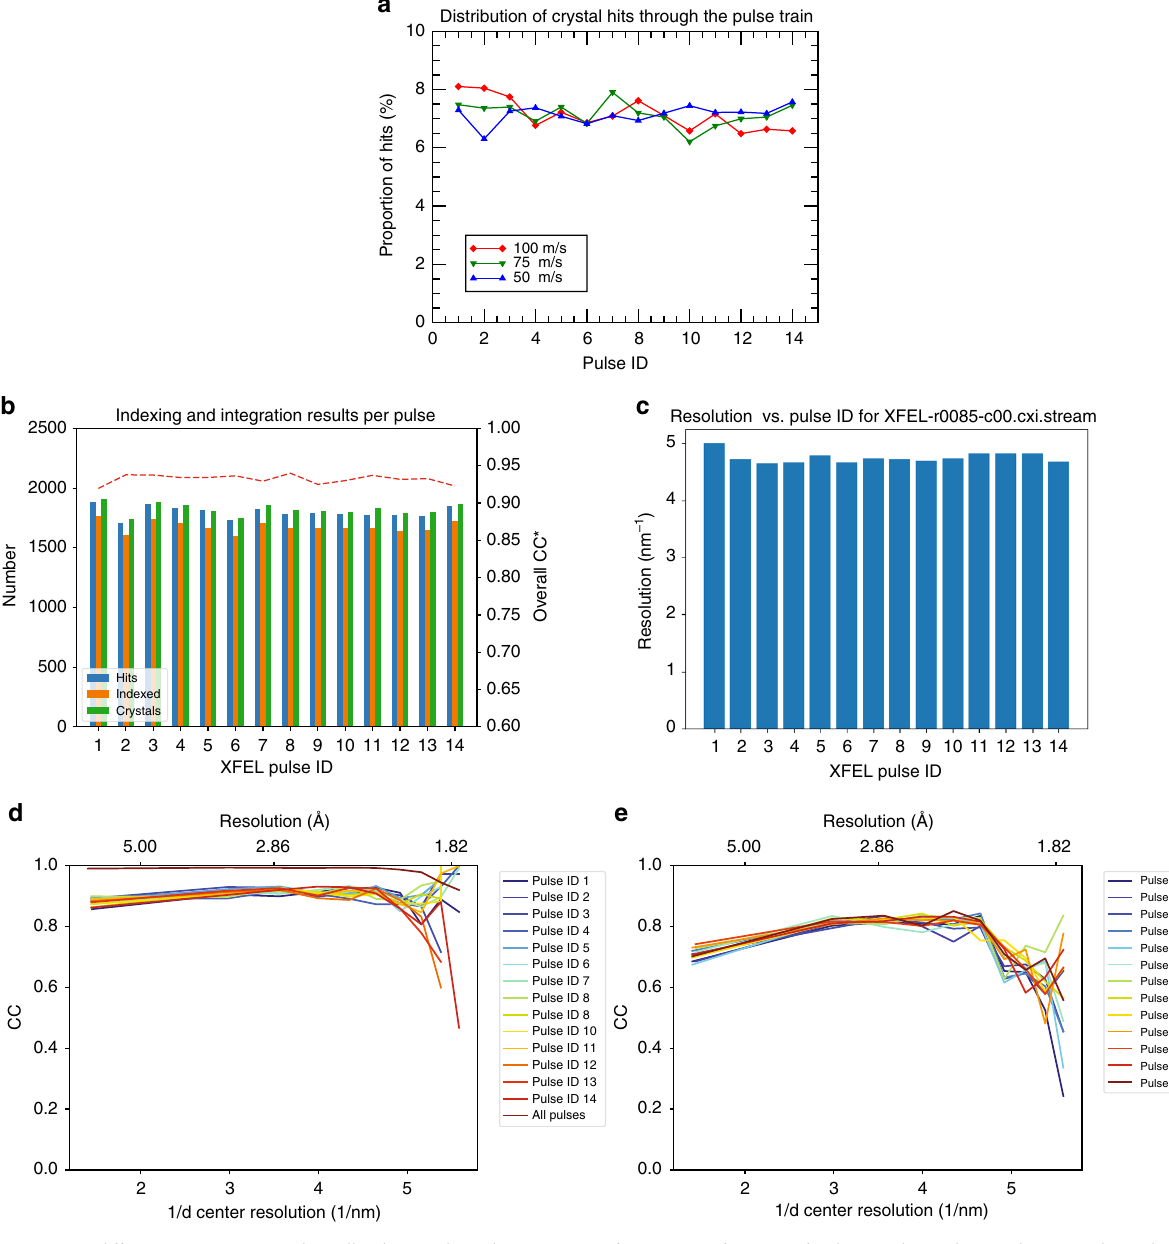
Fig. 4 HEWL diffraction was measured on all pulses in the pulse train. a Hit fraction as a function of pulse number indicates that crystals are hit randomly on any pulse within the MHz EuXFEL pulse train, and not only on the fi rst pulse in the pulse train. b Indexable lattices were equally distributed among the MHz XFEL pulse trains and no sign of degradation in data quality is observed through the pulse train as measured by the overall CC* for subsets of the data corresponding to each pulse. c CrystFEL resolution estimate as a function of X-ray pulse within a train shows no decrease in estimated resolution through the course of the pulse train. d CC* for data separated from each pulse indicates similar data quality for each pulse in the pulse train. Merging all pulses produces higher data quality (as expected). e Correlation of merged data from the fi rst pulse relative to each subsequent pulse in the pulse train indicates that data are similar on each pulse to the limit of data quality available in this experiment. Both d and e are generated from the same stream fi les used